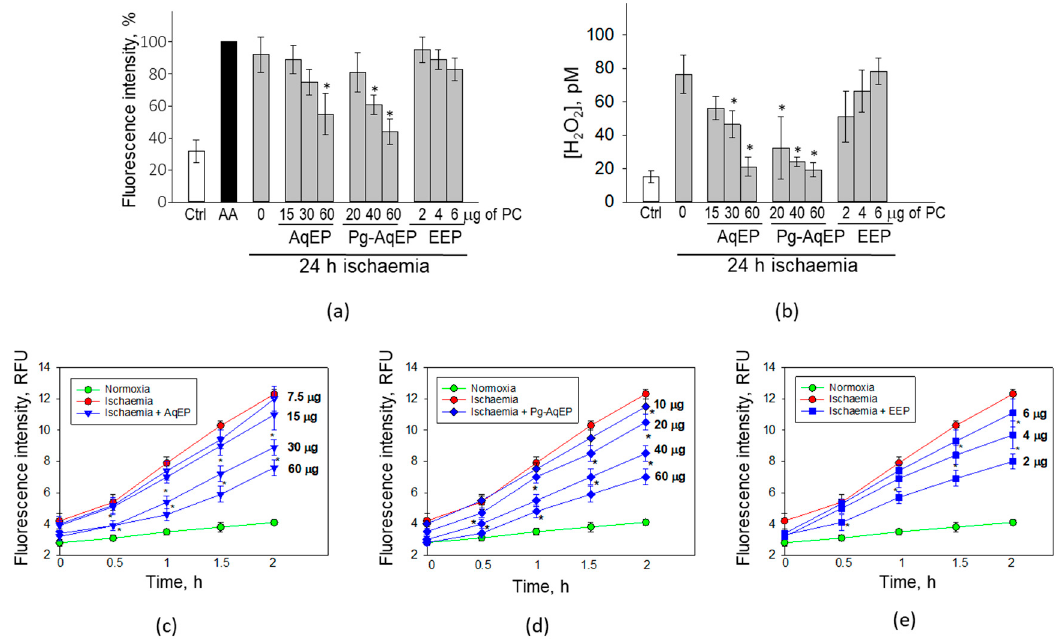
Figure 4. Reactive oxygen species (ROS) production in hypoxia-treated cerebellar neuronal-glial cells, with and without propolis extracts. ( a )—intramitochondrial superoxide assessed as MitoSOX fluorescence (30 min treatment with 100 µ M Antimycin A (AA) was applied as positive control); ( b )—extracellular level of hydrogen peroxide; ( c – e )—intracellular ROS level measured by DCFDA assay after ischaemia with and without AqEP ( c ), Pg-AqEP ( d ) and EEP ( e ). Concentrations of the extracts are indicated next to the curves. In ( a ), the data are expressed as the percentage of fluorescence with AA. All data are presented as the average ± SE of 3 experimental repeats performed in triplicate. *—statistically significant di ff erence compared with the simulated ischaemia samples (0), p < 0.05; ischaemia samples without the extracts were significantly di ff erent compared to the normoxic control at all time points, p < 0.001.